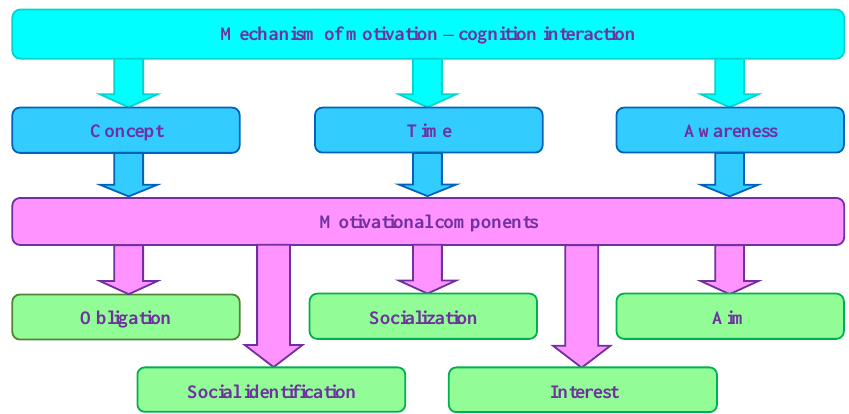
Figure 1. Motivational components in medical